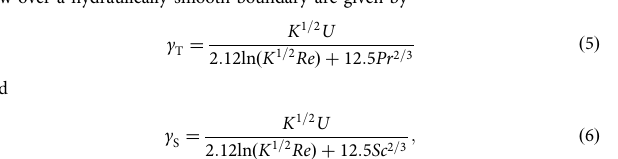
Fig. 6 Sea – ice condition in the Lützow-Holm Bay. Landsat 8 image showing the bay on ( a ) February 22, 2017 and ( b ) January 8, 2018. White solid and orange dashed lines indicate open water areas and the coastline of glaciers and land,